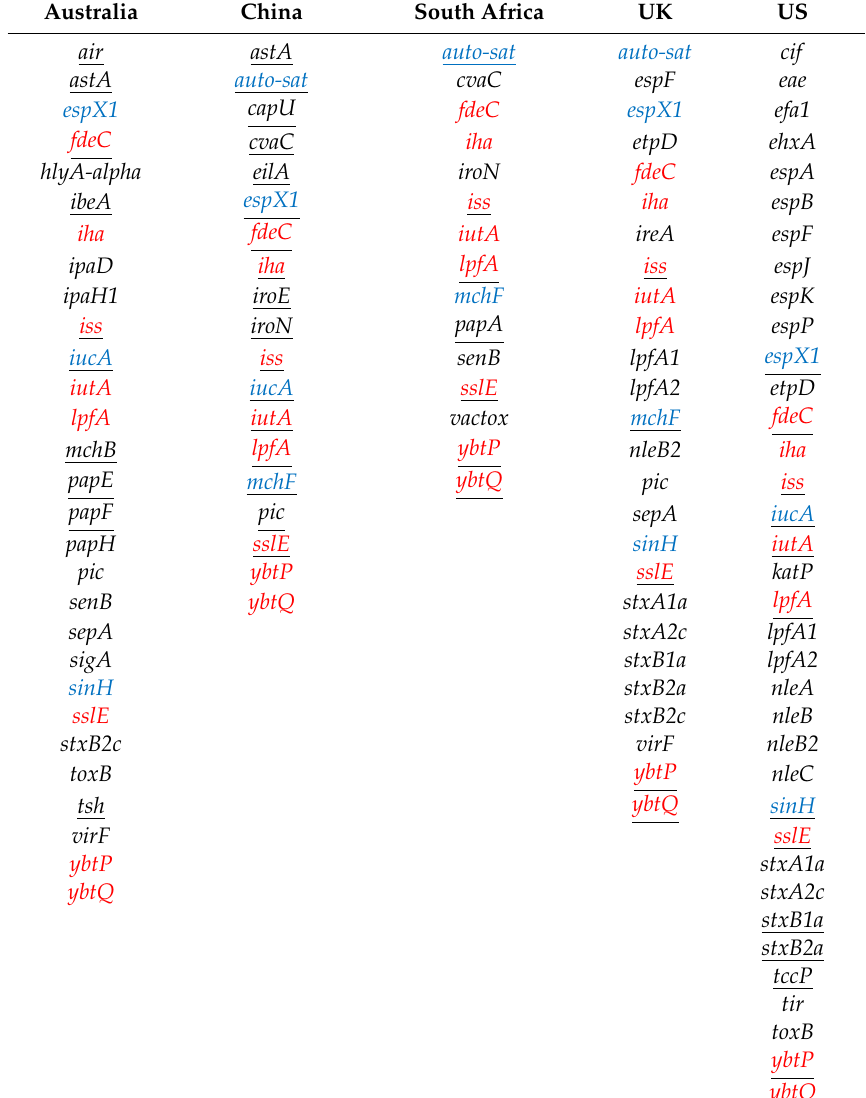
Table 1. The important virulence genes identified in the five countries. In red are the genes shared across each country, and in blue are the important genes identified in at least three di ff erent countries (note: underlined genes show generally increasing trend in their occurrence from